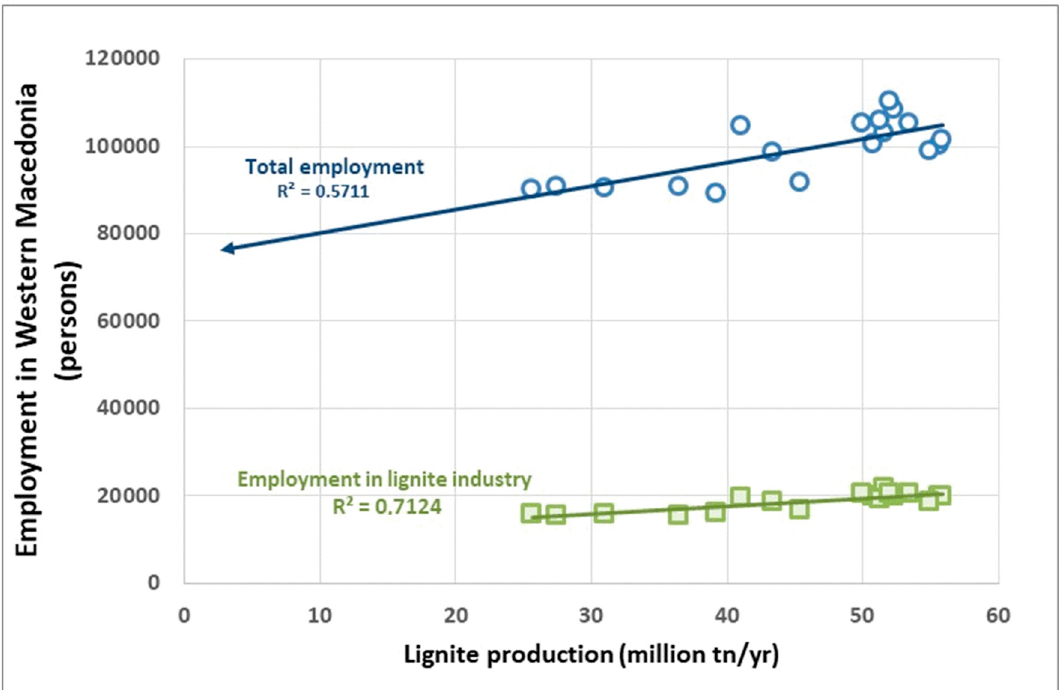
Figure 4. Lignite production and employment in western Macedonia.